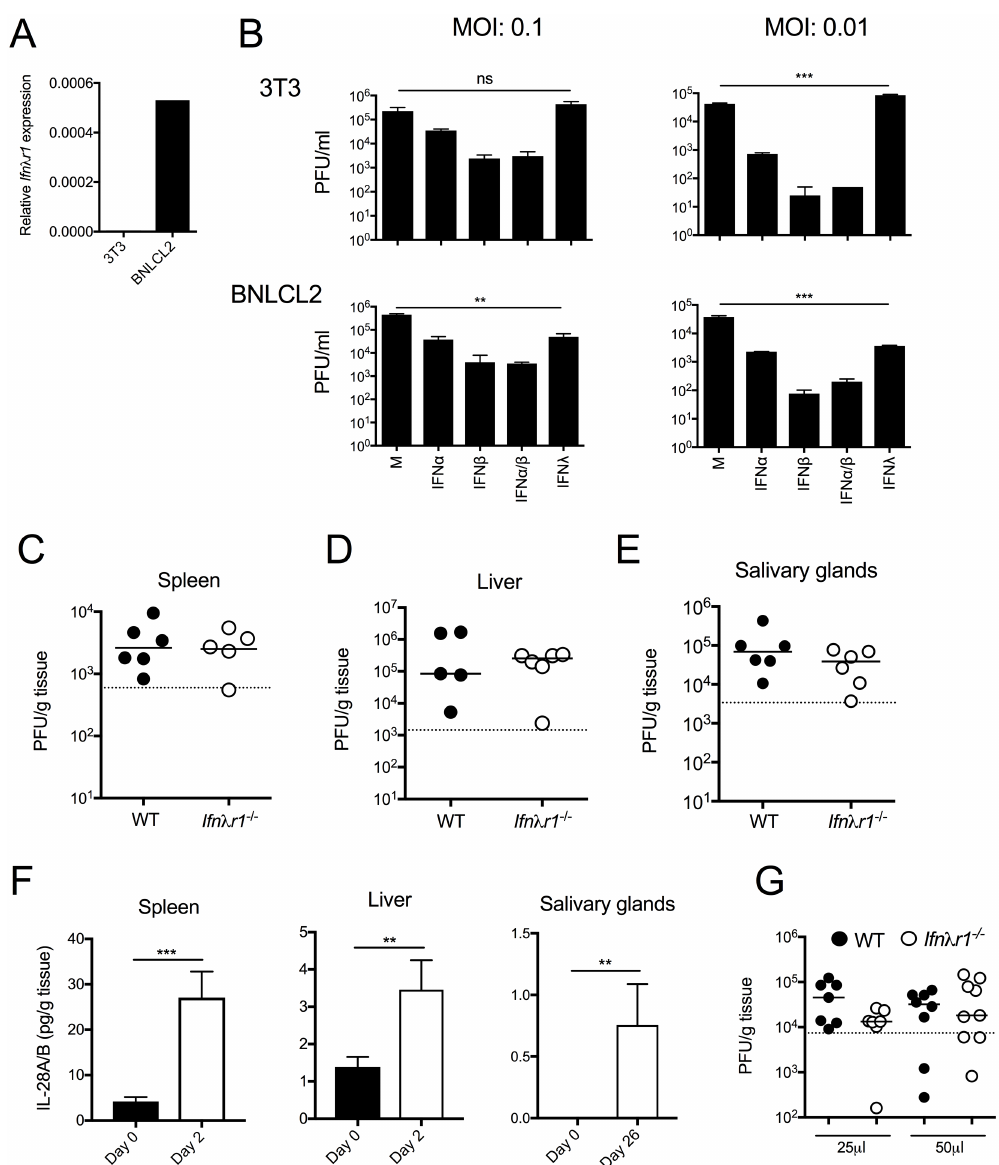
Fig 1. IFN λ can restrict mCMV replication in vitro . (A) Ifn λ r1 expression by 3T3 and BNLCL2 cells was determined by qPCR. (B) 3T3 (top) and BNLCL2 (bottom) cells were incubated with/without 50U/ml IFN α and/or IFN β , or 50ng/ml IFN λ 2 (IL-28A) for 24hrs and infected with mCMV at multiplicities of infection (MOI), as stated in the figure. After 4 days, infectious virions in supernatant were quantified by plaque assay. Statistical significance of PFU in IFN λ 2-treated versus control cells is shown. Virus load in spleen (C), liver (D) and salivary glands (E) of WT and Ifn λ r1 -/- mice was assessed 4 (D&E) and 33 (E) days p.i. (F) IFN λ 2/3 protein in spleen (left), liver (middle) and salivary glands (right) was measured at day 0 and 2 days p.i (spleen and liver) or 0 and 26 days p.i (salivary glands). Results are shown as mean + SEM of 3–7 mice/group. (G) WT and Ifn λ r1 -/- mice were infected (i.n) with mCMV in a volume of 25μl or 50μl and after 4 days, lung infectious viral load was quantified by plaque assay. Statistical significance was assessed using 1-way ANOVA (B) or Mann Whitney-U (C-E, G) or students T-Test (F) and is depicted where appropriate. Panel G represents merged data from two experiments whereas all other data represent at least two biological replicates performed